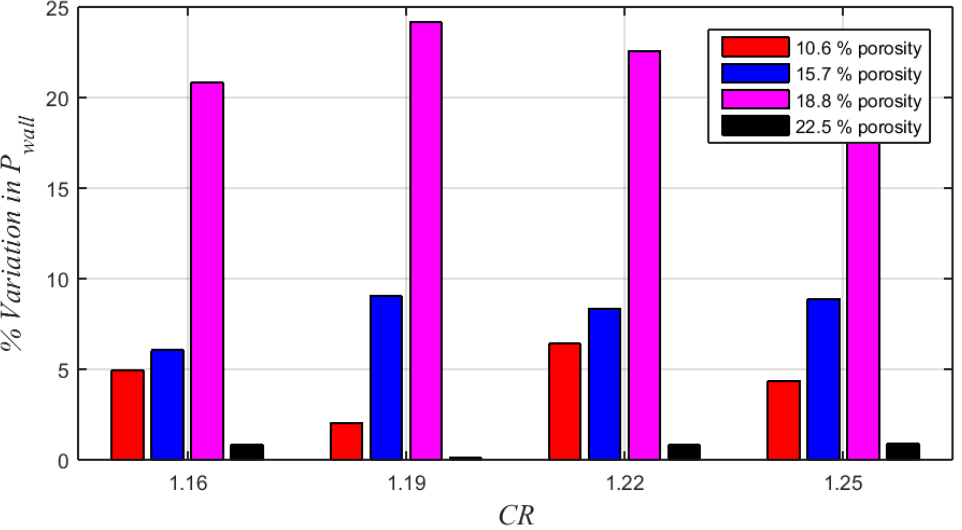
Figure 16. Variations of wall static pressure for the controlled intakes at various contraction ratios (X = 0.48 L). Table 4. Variation of wall static pressure percentage due to wall ventilation at the downstream proximity (X/L = 0.7).